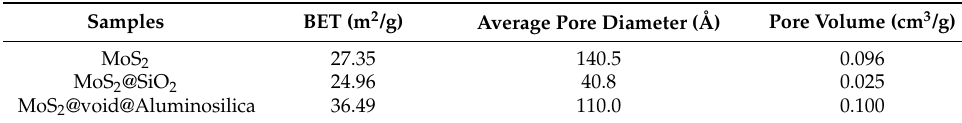
Table 1. Some physical properties of the three main